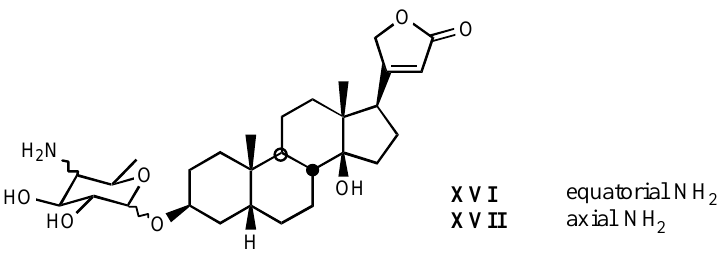
Figure 15. Structure of some derivatives bearing aminosugars.